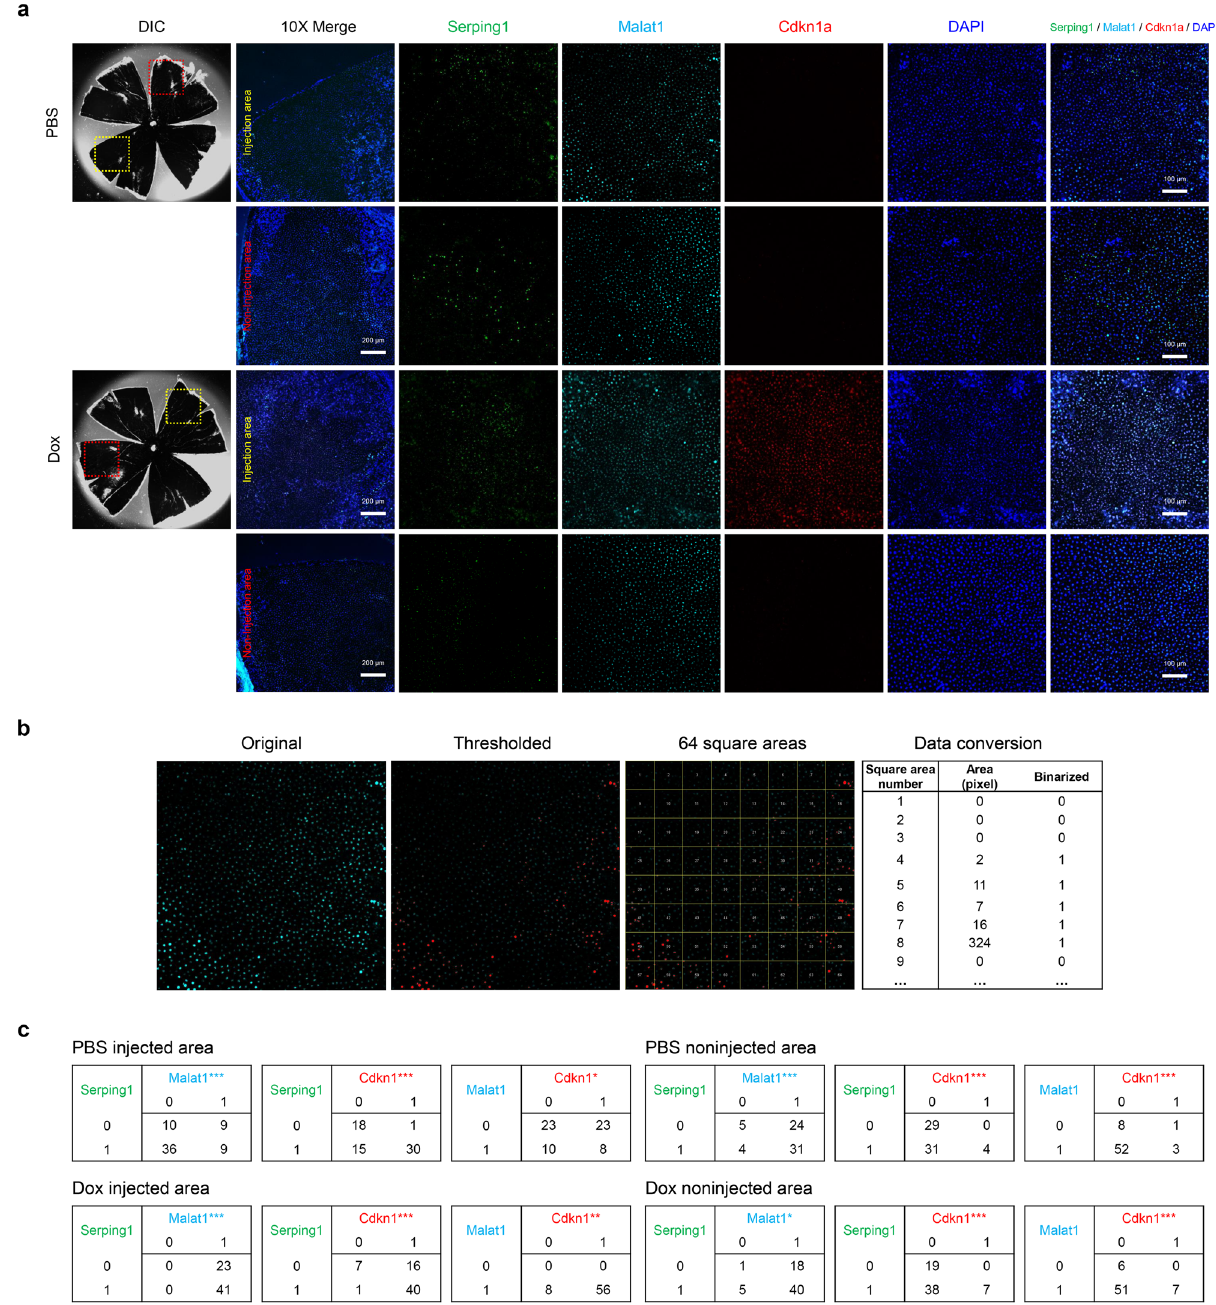
Fig. 6 RNA fl uorescence in situ hybridization of RPE subpopulations in control RPE and Dox-RPE. a Images showing mRNA expression of Serping1 (green), Malat1 (cyan) and Cdkn1a (red), selected markers for RPE subpopulations 2, 3, and 4, respectively. Nuclei were counterstained with DAPI. Differential interference contrast (DIC) images represent the whole shape of the RPE fl atmount and the inspected location in the injected area (yellow box) and noninjected area (red box). b Image processing to represent spatial distributions as series of numbers. The original image was binarized by an arbitrarily determined threshold to represent the spatial distribution of a marker, and the whole image was divided into 64 square areas. Then, the information about expression in each square area was marked as 1 or 0 according to the presence or absence of a signal inside. c 2 × 2 contingency tables between 2 markers in four environments of the same RPE fl atmount in PBS-injected/ noninjected areas, Dox injected/noninjected areas. Statistical analyses were performed using McNemar ’ s test (* p < 0.05, ** p < 0.01, *** p < 0.001). Scale bar: 200 μ m for the 10× merge image ( fi rst column) and 100 μ m for ×20 magni fi cation (next columns on the right side) in a . PBS = RPE fl atmount from the PBS injected mouse; Dox = RPE fl atmount from the Dox- injected